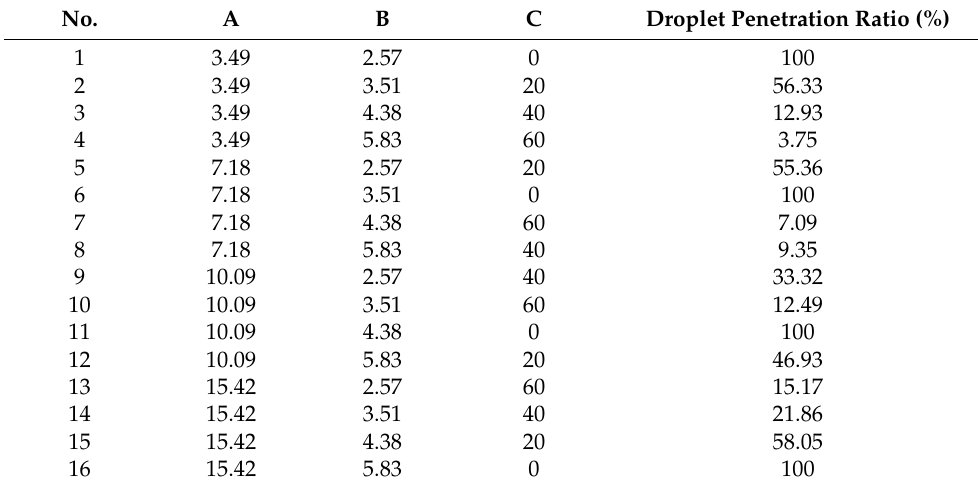
Table 14. The results of three-factor and four-level orthogonal